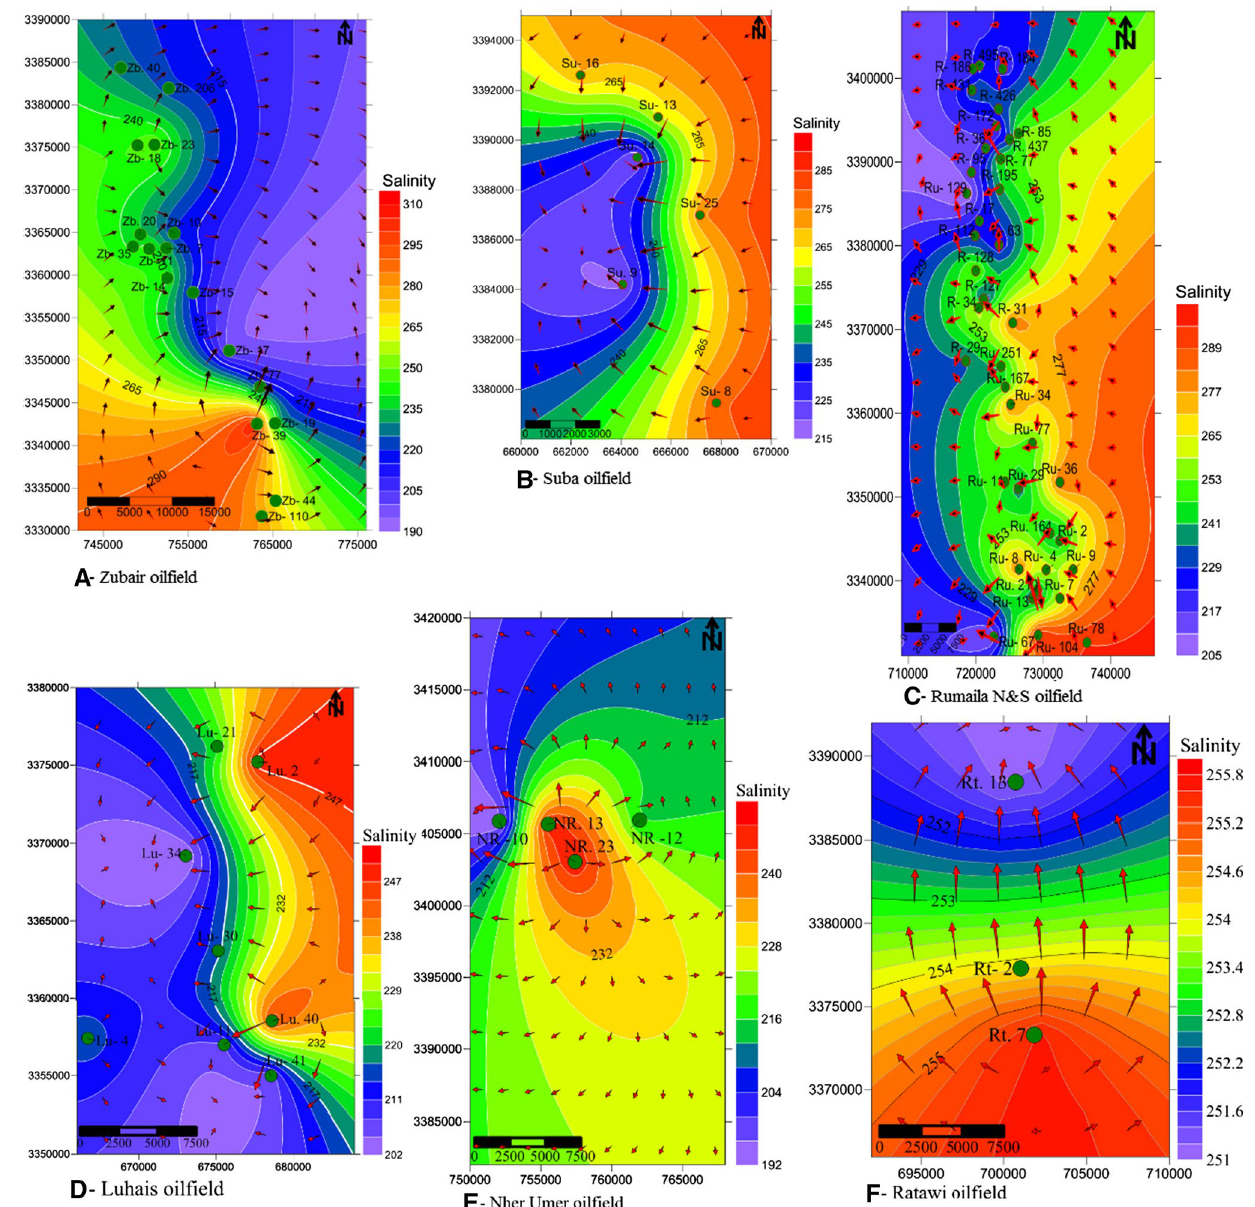
Fig. 7 Isosalinity map and probable flow path of a , Zubair, b Suba, c Rumaila N and S, d Luhais, e Nhar Umer, f Ratawi